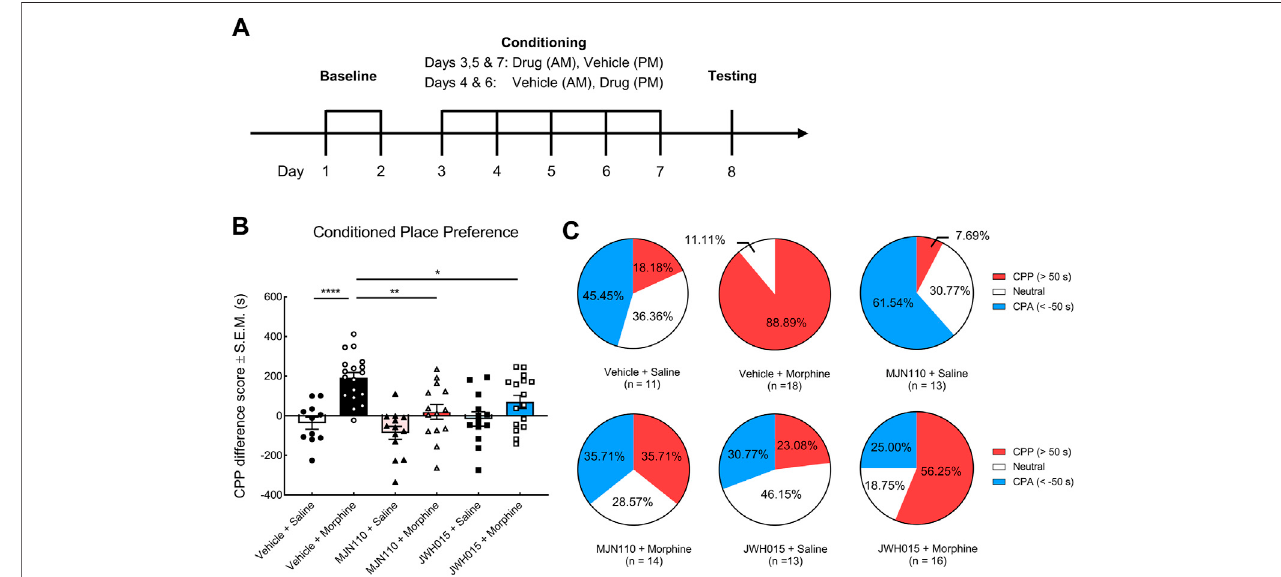
FIGURE 5 | The effects of systemic MJN110 and JWH015 on the sustained morphine-induced conditioned place preference. Conditioned place preference was employedtoinvestigatethemodulatoryeffectsofaselectiveMAGLinhibitor,MJN110,andaselectiveCB2Ragonist,JWH015,onsustainedmorphine-inducedreward. (A) Experimental design of conditioned place preference assay. After baseline testing to establish approximate equal times in the two end chambers, rats were paired witha treatment and one of theend chambers for 5 ° days. Their chamber preference (access to all chambers) wastested on day 8 with no treatment administered. (B) Ratsthatreceivedsustainedmorphinepresented astrong preferencetowardthedrug-pairedchamberbut notsaline-treatedrats.MJN110 signi fi cantlysuppressed morphine-inducedpreference.MJN110mayproduceaversiveeffectonratsbutnostatisticdifferencewasobservedcomparedtotheresultsfromvehicle-saline-treated rats. JWH015 attenuated morphine-induced preference but did not alter the preference in saline-treated rats. (C) Pie plots showing the percentages of rats exhibiting conditioned place preference, aversion or no preference. CPP (red): Animals presenting remarked conditioned place preference (CPP difference score > 50 ° s); CPA (blue): Animals presenting remarked conditioned place aversion (CPP difference score < − 50 ° s); Neutral (white), Animals presenting no remarked preference or aversion (CPP difference score between − 50 and 50 ° s). or * p < 0.05, ** p < 0.01, **** p < 0.0001. Values represent the mean ± SEM, n (cid:1) 11 – 18 per